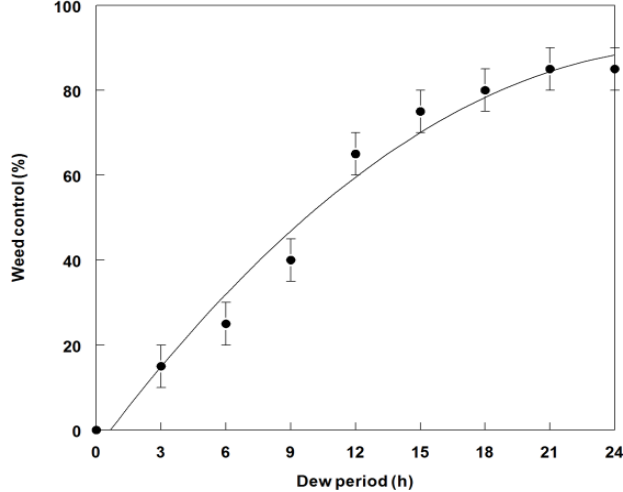
Figure 4. Effect of dew period duration at 25 °C on weed control of spreading dayflower inoculated with P. commelinicola at 1.0 × 10 8 under greenhouse conditions. Error bars represent Fisher’s LSD ( p =